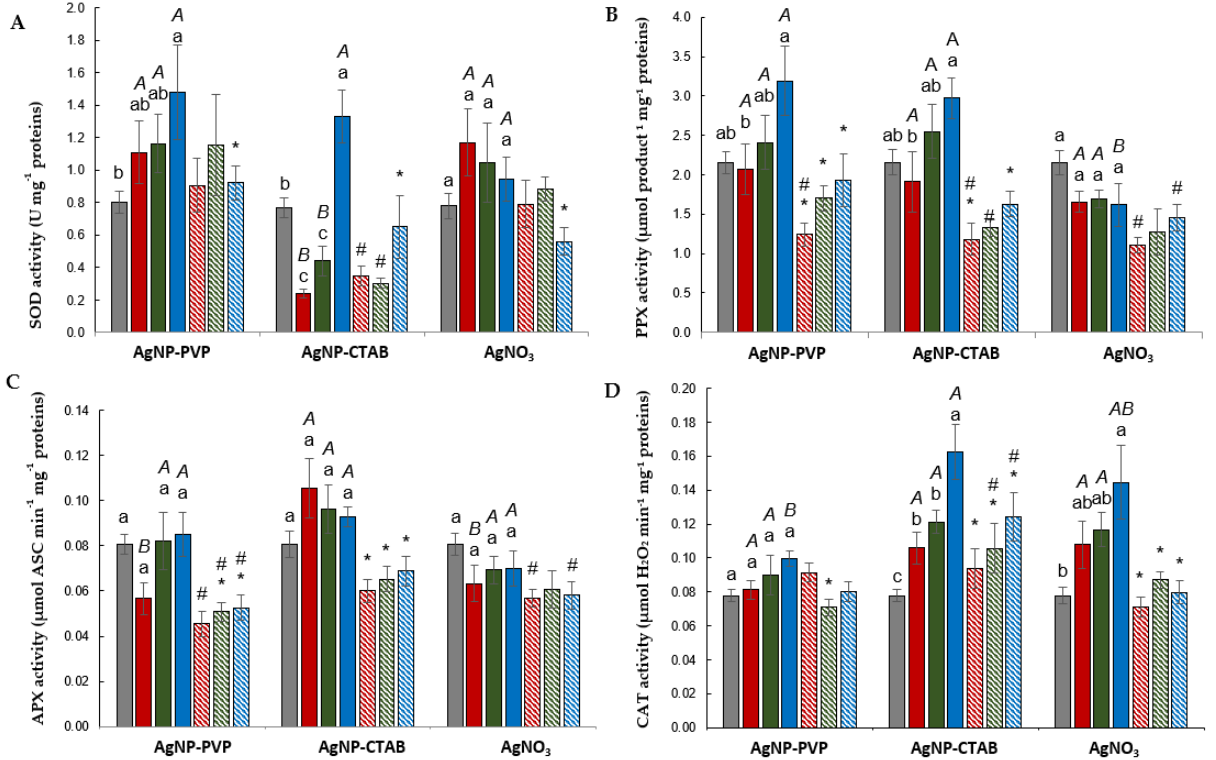
Figure 2. Differences in activites of ( A ) superoxide dismutase (SOD), ( B ) pyrogallol peroxidase (PPX), ( C ) ascorbate peroxidase (APX), and ( D ) catalase (CAT) in leaves of tobacco plants 7 days after exposure to 25, 50, and 100 µ M AgNP–PVP, AgNP–CTAB, and AgNO 3 , applied either alone or in combination with 125, 250, and 500 µ M cysteine (cys). Values are the means ± SE of three biological replicates, each with six technical replicas. If columns are marked with different letters, the treatments are significantly different at p ≤ 0.05 (a two-way ANOVA followed by Duncan’s post hoc test); small letters mark the differences among different concentrations of the same treatment type as well as control; capital letters mark the differences among different treatment types of the same concentration; asterisk (*) denotes significant differences among treatments with and without cysteine of the corresponding concentration, while hash sign (#) denotes significant difference between each treatment with cysteine and control.